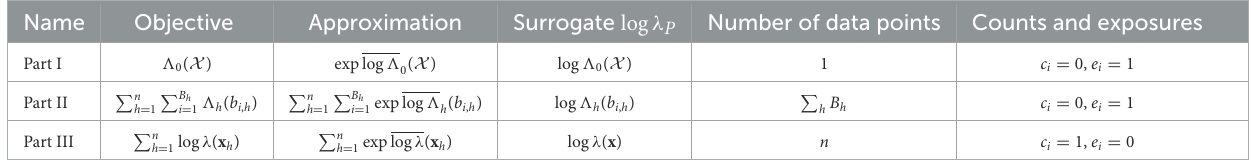
TABLE 1 Hawkes process log-likelihood components